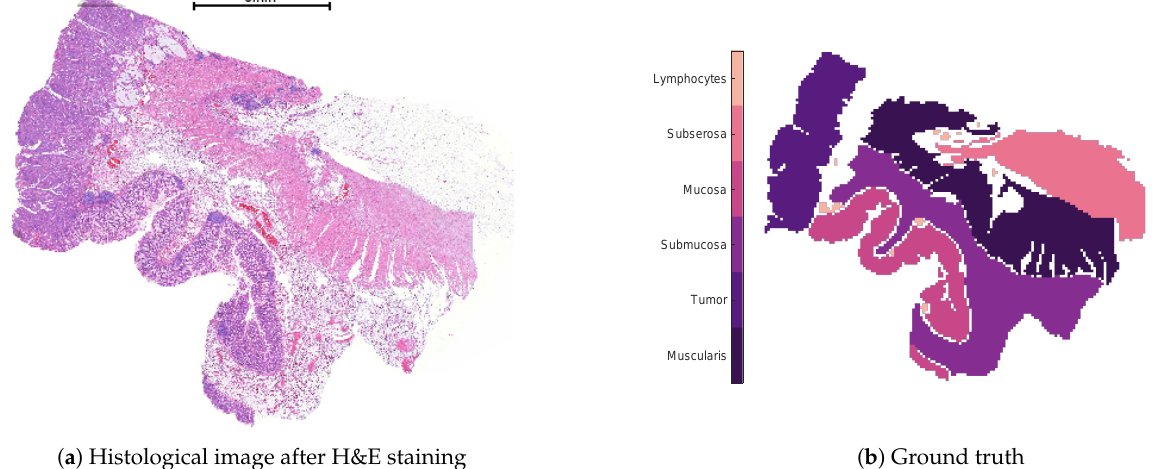
Figure 1. Histological image of the considered MALDI dataset after H&E staining ( a ) and the histological annotation ( b